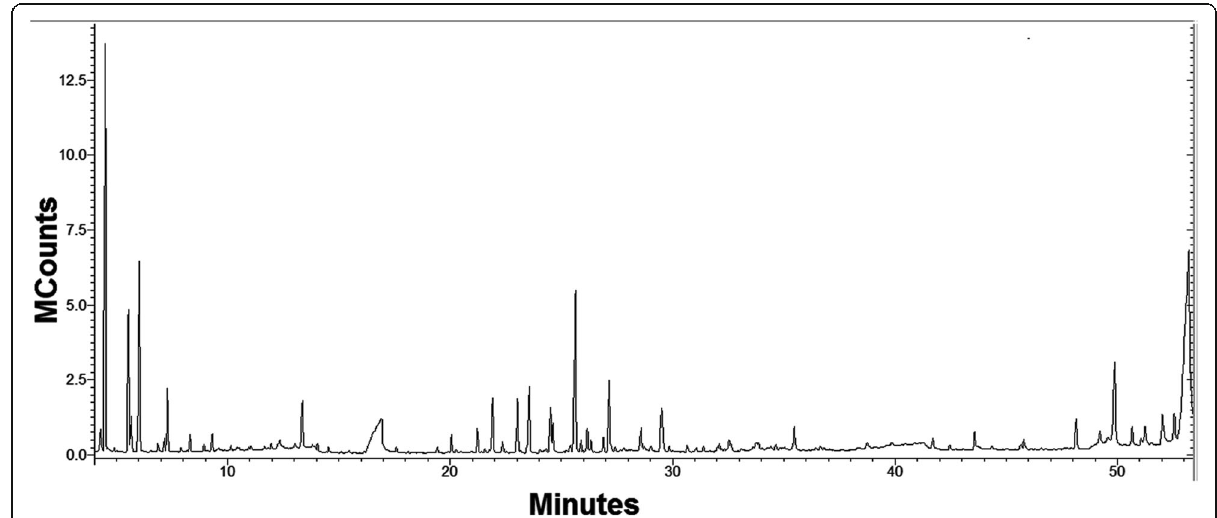
Fig. 2 GC-MS chromatogram of the juniper